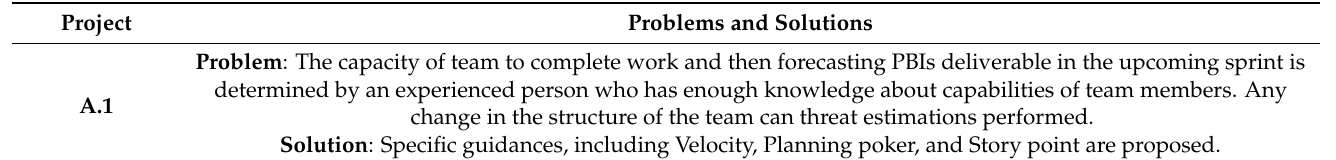
Table A6. Problems identified through interview sessions and the solutions proposed for each.